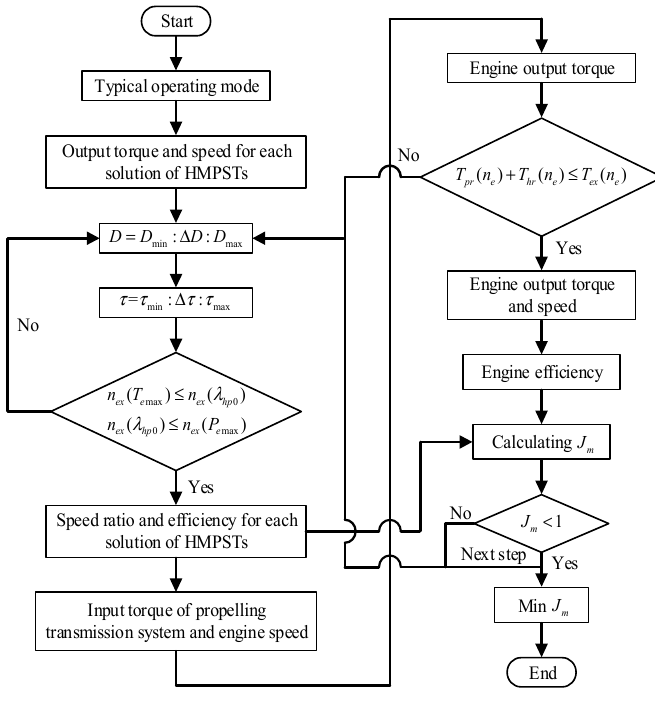
Figure 12. Solving flow chart.